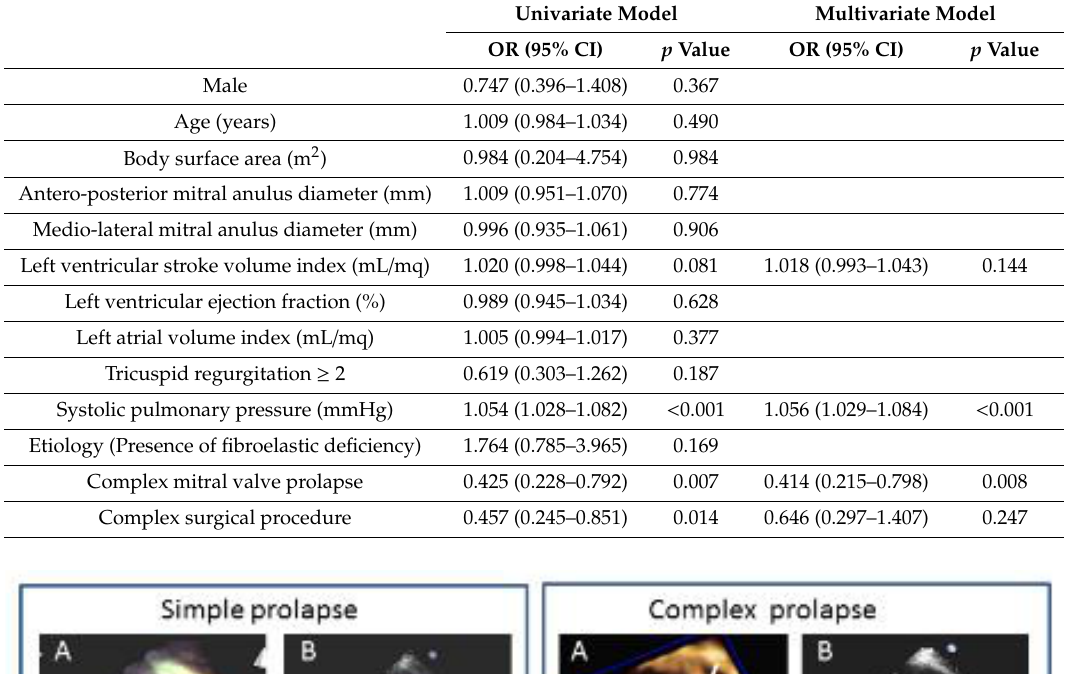
Table 5. Results of univariate and multivariate analysis for the identification of independent variables predicting residual mitral regurgitation ≥2.